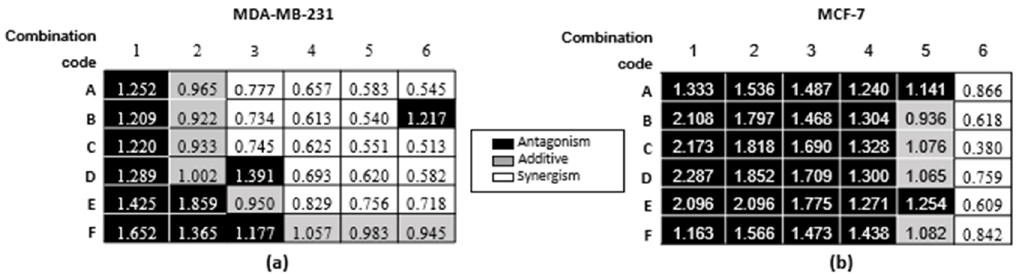
Figure 3. Combination index (CI) values were calculated of each cannabinoid combination at the respective growth inhibitions induced in the ( a ) MDA-MB-231 and ( b ) MCF-7 cell lines.